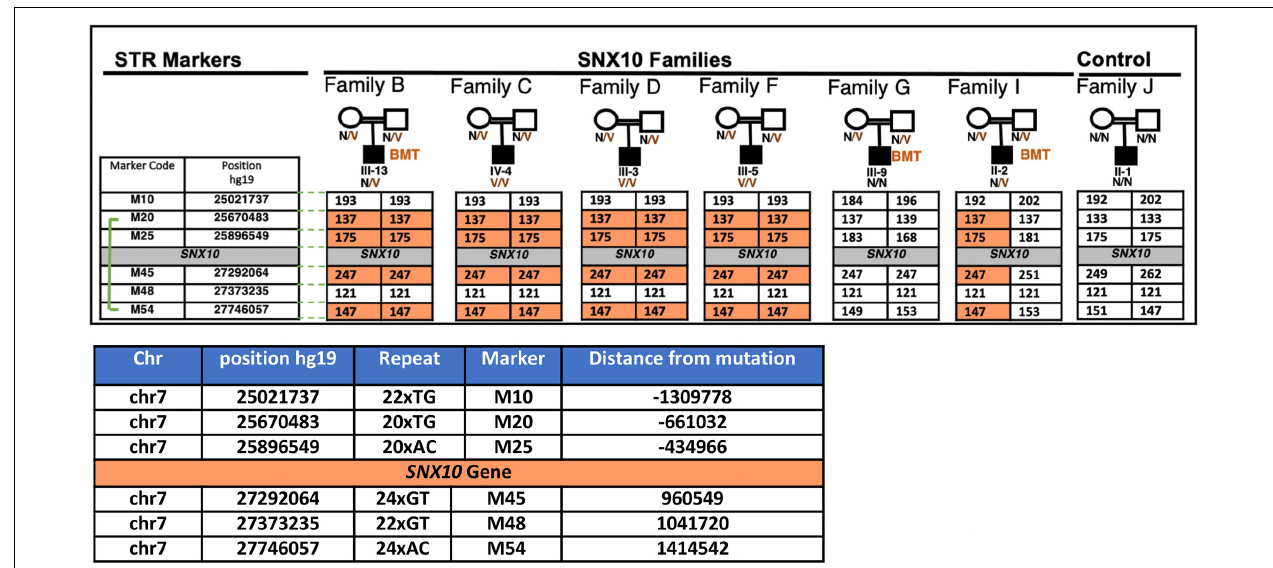
FIGURE 4 | Haplotype analysis of the SNX10 locus in affected Palestinian families from the village of Karma. Six microsatellite repeat markers that flank the SNX10 gene, three on either side, were selected and amplified by PCR using fluorescent labeled primers and examined by capillary electrophoresis (CE). Haplotype analyses were analyzed using GeneScan. Selected markers were tested on SNX10 positive families on the affected individual and the parents, one heterozygous sibling (not shown here). Haplotype analysis revealed that all Karma patients who are homozygous for p.R51Q mutation were also homozygous for all studied markers. BMT denotes patients who had undergone hematopoietic stem cell transplantation prior to analysis. Different haplotypes were found in unrelated OST-J Family ( Figure 3 ), as expected. The minimum shared haplotype block (orange) linked to the mutation was found in all the affected SNX10 patients. For each repeat the following parameters are provided: its position [according to the Human Genome Assembly GRCh37 (hg19), https://www.ncbi.nlm.nih.gov/assembly/GCF_000001405.13/], the length and composition of the nucleotide repeat, and its distance in bps from the R51Q mutation in the SNX10